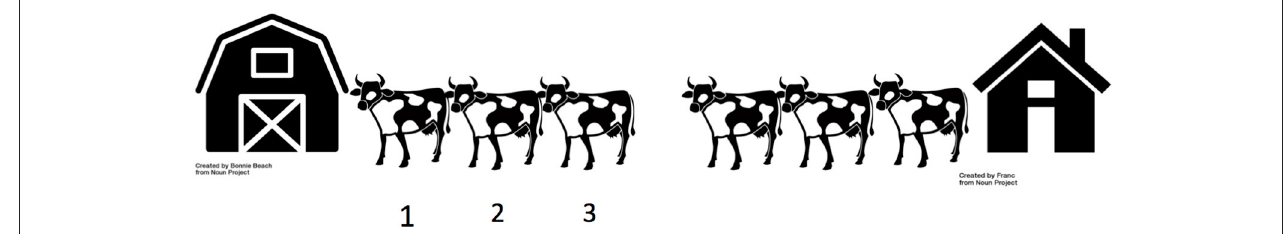
FIGURE 1 | Schematic representation of experimental display. Animals are numbered starting from the closest to the barn (cows by James Keuning, The Noun Project, copyright